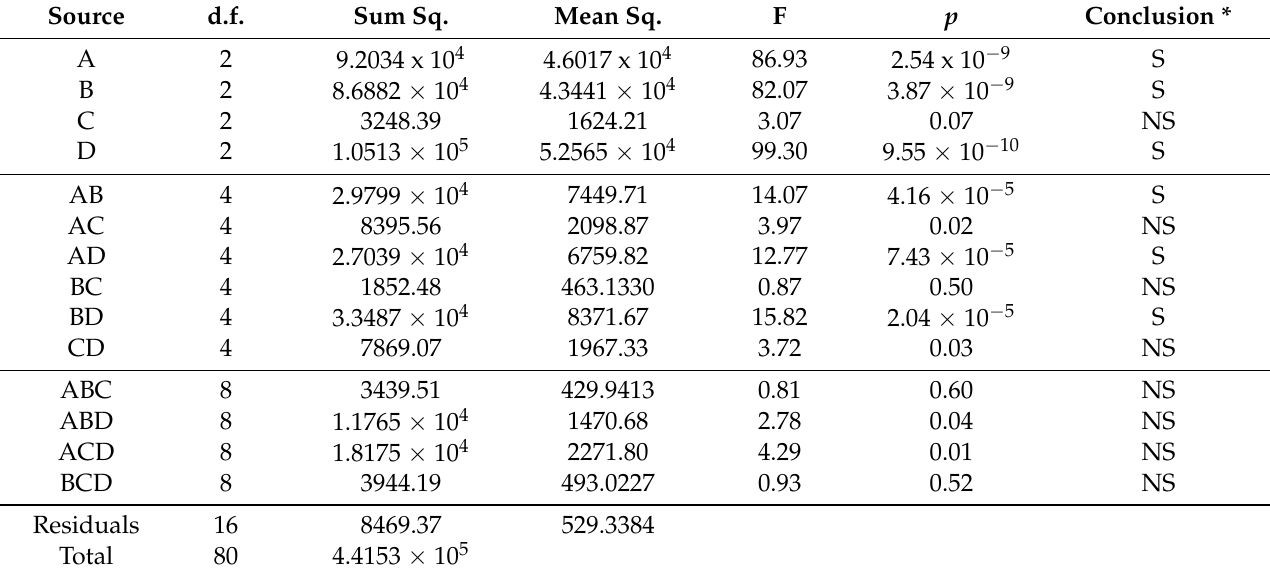
Table 7. Toughness results for the four-factor ANOVA.